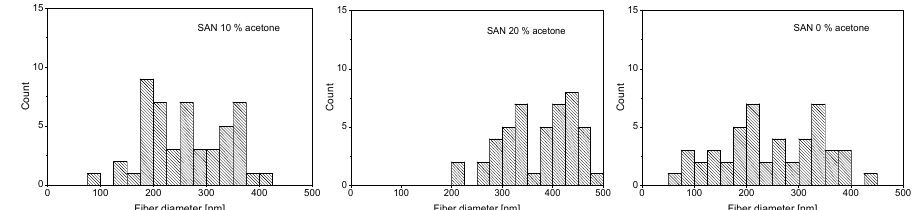
Figure 1. Helium ion microscope (HIM) images of acrylonitrile butadiene styrene (ABS), poly(vinyl alcohol ‐ co ‐ ethylene) (EVOH), and poly(styrene ‐ co ‐ acrylonitrile) (SAN) nanofibers spun from different DSMO:acetone weight proportion of ( a , d , g ) 100:0, ( b , e , h ) 90:10, and ( c , f , i ) 80:20, with respective histograms of fiber diameter distributions.